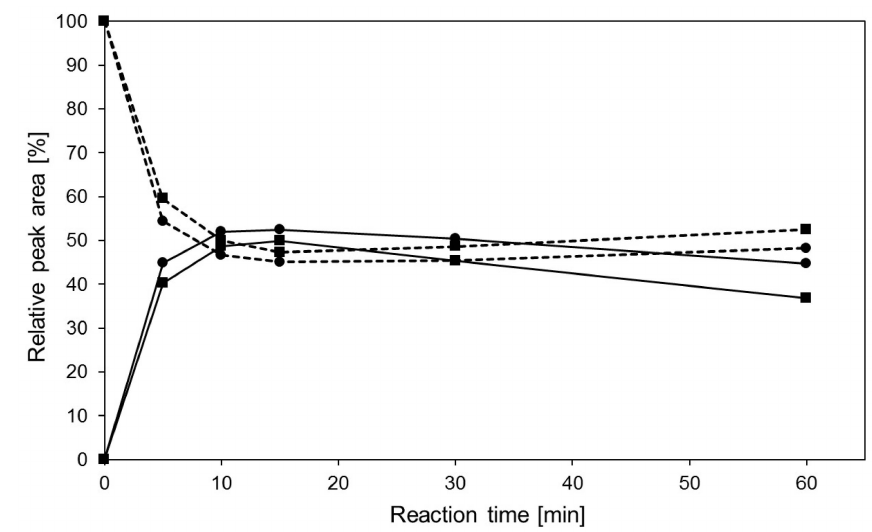
Figure 5. Transgalactosylation recombinant β -glycosidase from Pyrococcus under thermal heating at 85 ˝ C ( (cid:4) ) with 12 U/mL in comparison with transgalactosylation under MWI at 300 W ( ) (average temperature of ~35 ˝ C) including a five times higher enzyme activity (60 U/mL). Samples were separated on analytical HPLC at 254 nm: GlcNAc-linker- t Boc (dashed lines) and main product (Gal( β 1,4)GlcNAc-linker- t Boc, solid lines). In addition, 1 mL reaction mixture contained 50 mM GlcNAc-linker- t Boc and 600 mM lactose in 25 mM citrate-phosphate buffer pH 5.5. The measured